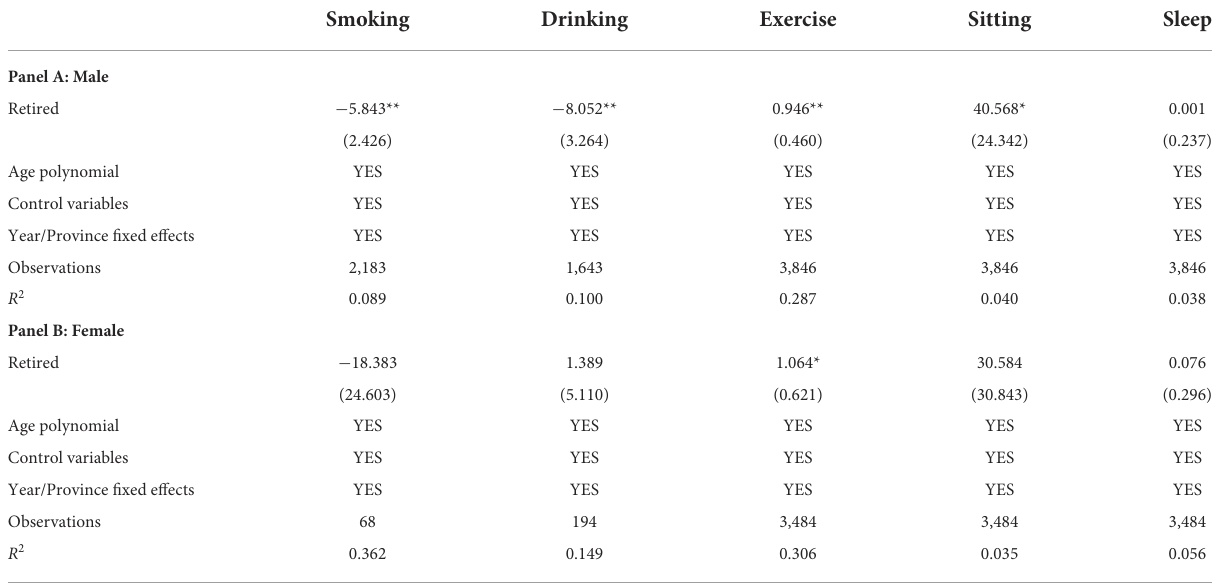
TABLE 4 Heterogeneity by